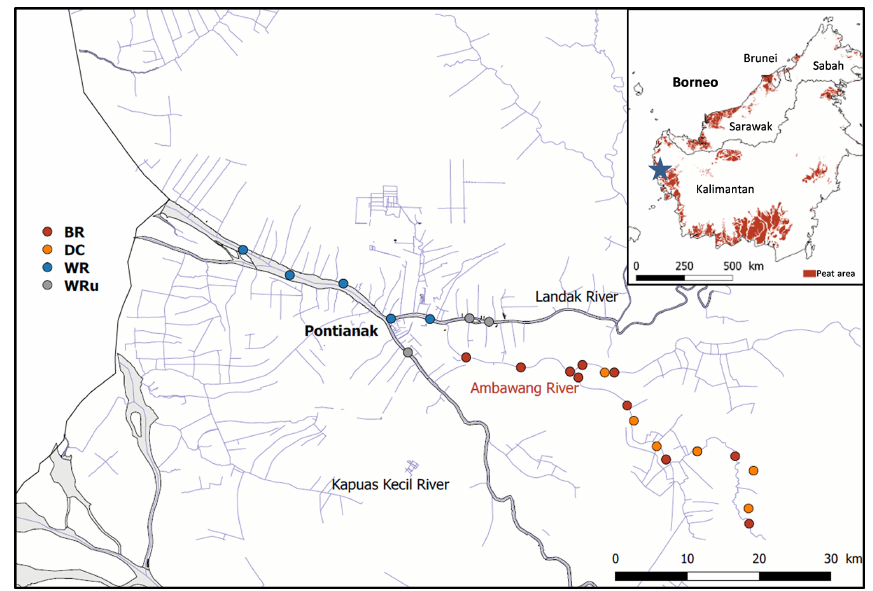
Figure 1. (a) Location of the study area on the island of Borneo. (b) Location of sampling sites and types of water: blackwater river (BR), drainage canal (DC), whitewater river (WR) and whitewater river upstream of the confluence with the blackwater river